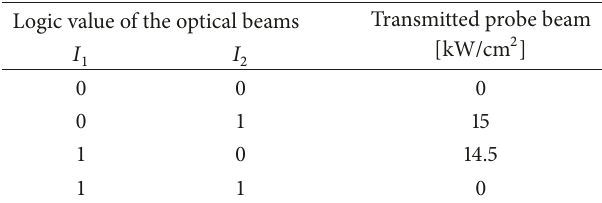
Table 1: XOR logic gate results. Logic value of the optical